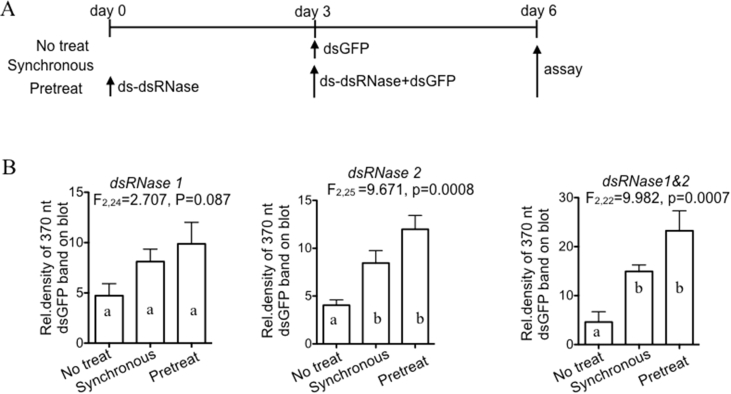
Effect of RNAi against dsRNase on the abundance of ds-GFP administered orally to whiteflies. (A) Experimental design. 200 ng μl−1 of each ds-dsRNase and 500 ng μl−1 of ds-GFP were fed to the whiteflies. (B) Relative density of the 370 nt ds-GFP bands on northern blots (mean ± s. e, 3 replicate experiments), with ANOVA results and significantly different treatments by post hoc test indicated by different letters. The northern blots are displayed in Fig. S3.